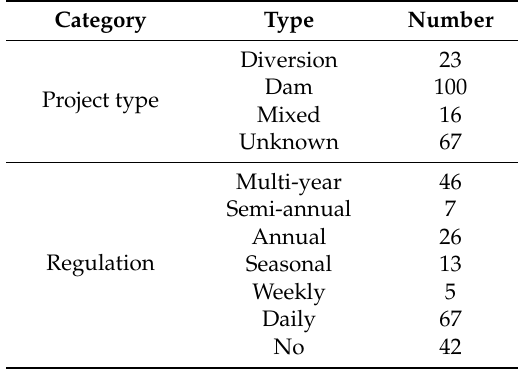
Table 1. Functional statistics of the water storage and hydropower projects.